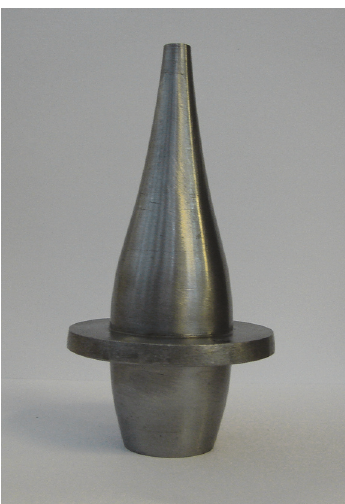
Figure 3: The physical model of the horn.